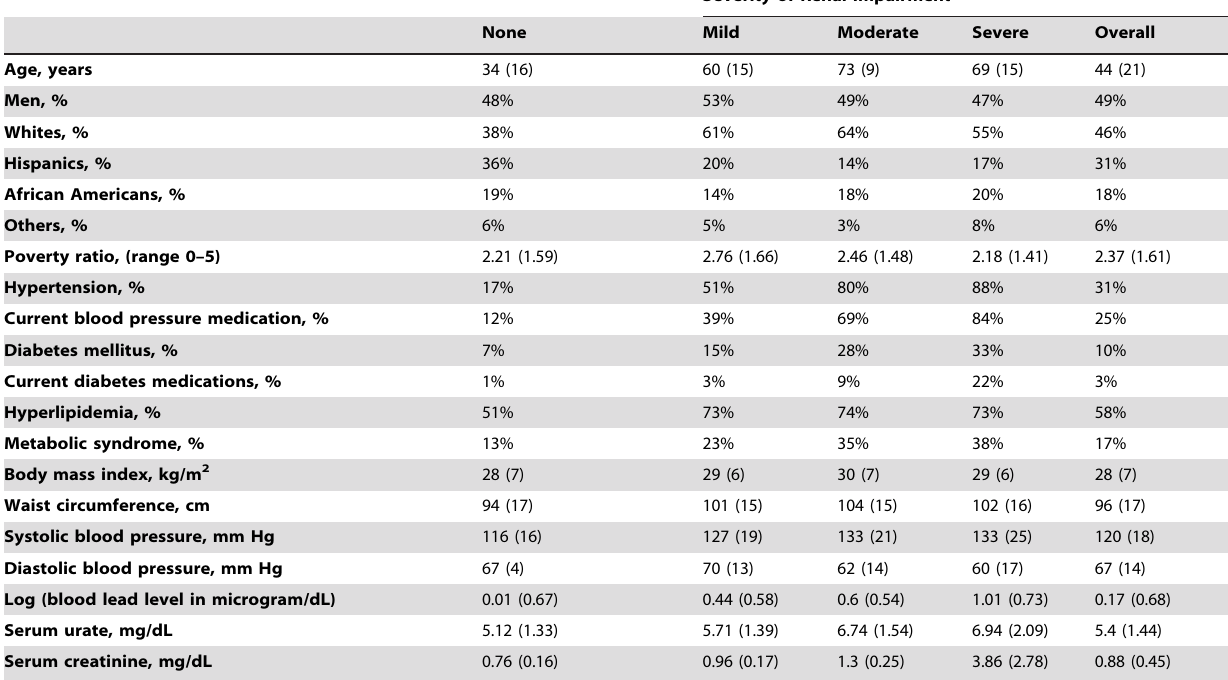
Table 1. Comparison of participants by renal function.